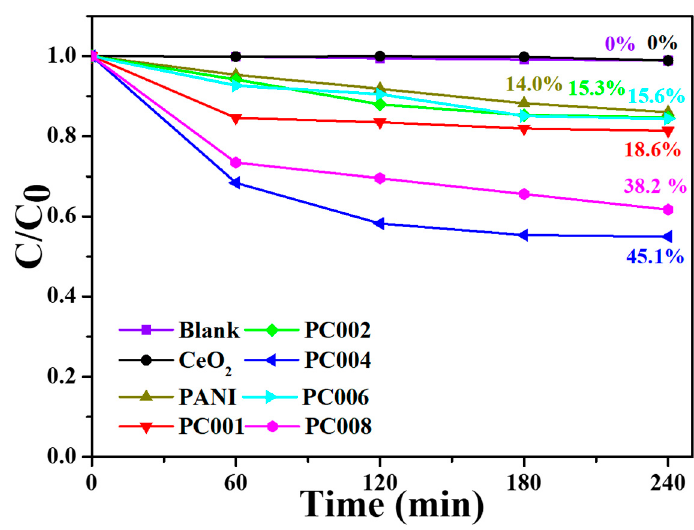
Figure 9. Photocatalytic MO degradation curve of the heterostructured CeO 2 / PANI powders under visible light irradiation as a function of the amount of PANI coating.